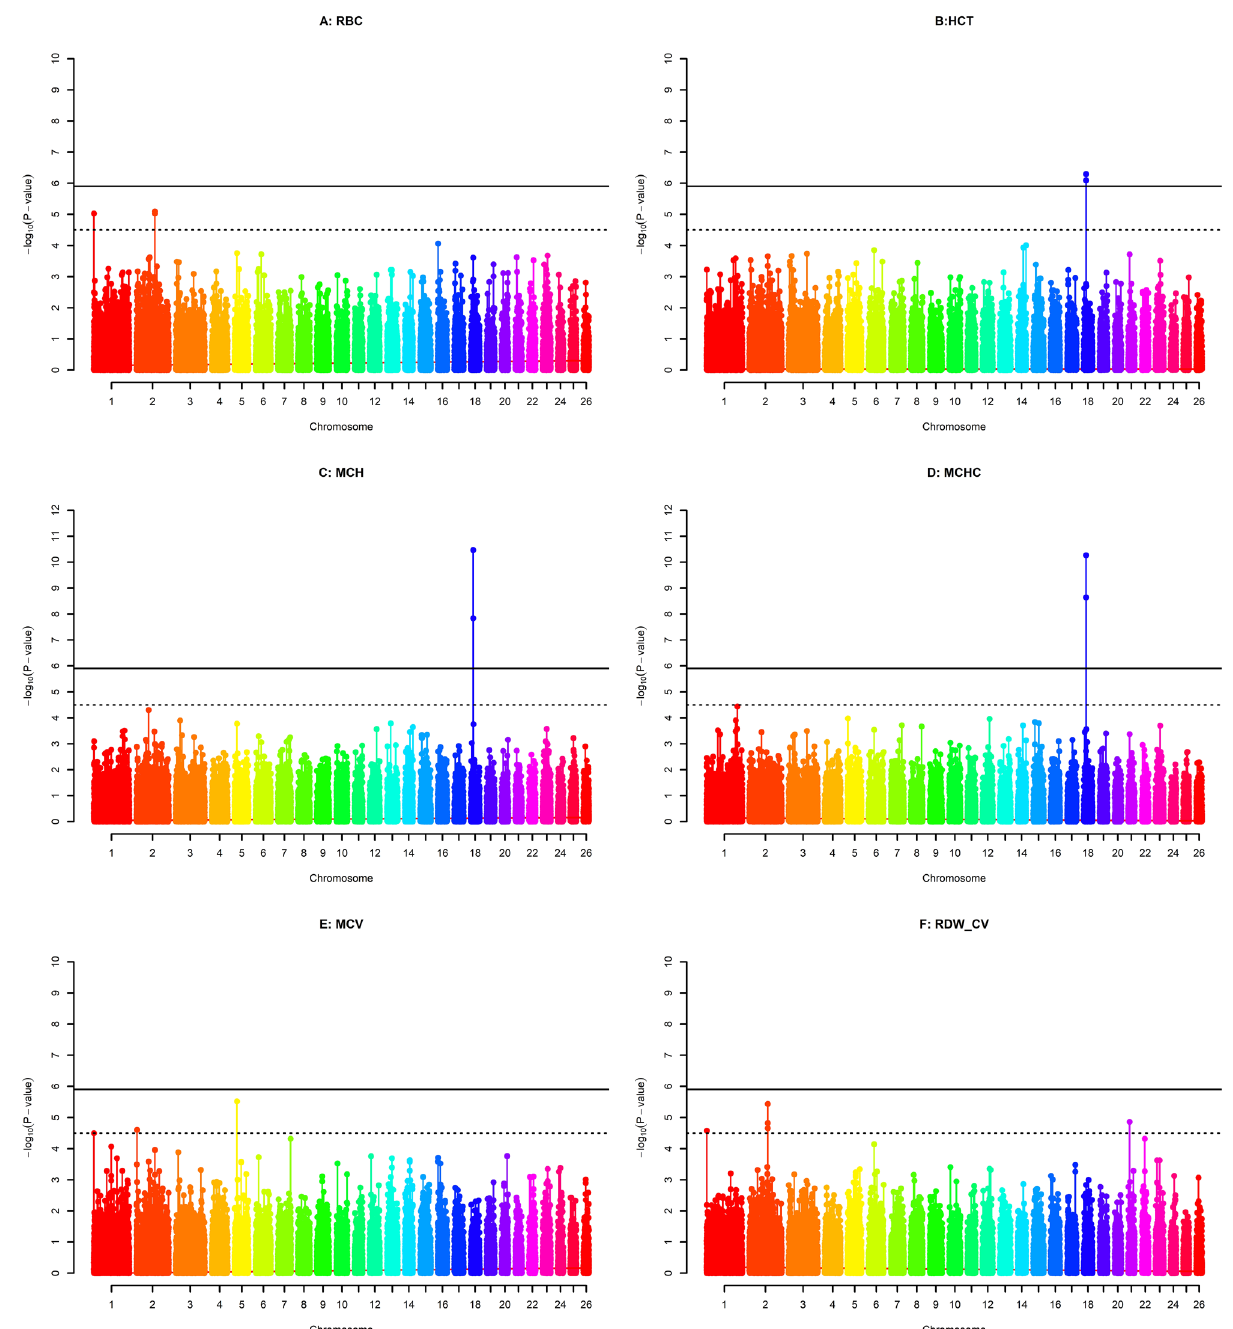
Figure 1. Manhattan plots of GWAS for six erythrocyte traits. Red dashed lines (i.e., upper line) represent Bonferroni-corrected genome-wide significance level, while black dashed lines (i.e., lower line) are for Bonferroni-corrected chromosome-wide significance level. The six traits were: red blood cell count ( A ), hematocrit ( B ), mean corpuscular hemoglobin ( C ), mean corpuscular hemoglobin concentration ( D ), mean corpuscular volume ( E ) and RBC volume distribution width coefficient of variation ( F